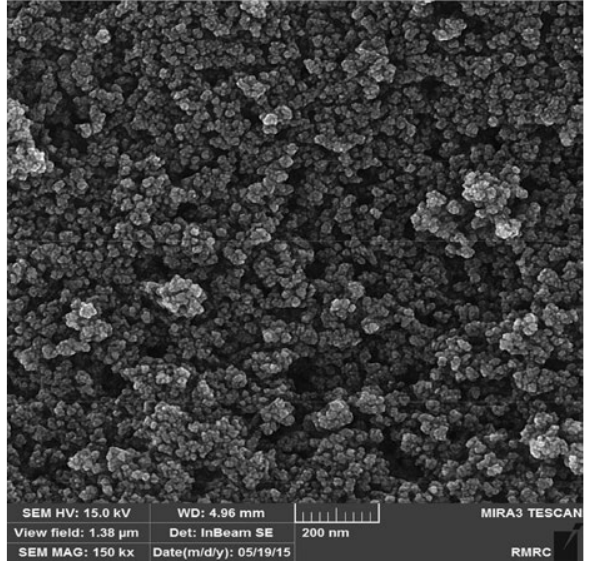
Figure 1. FE-SEM image of Fe O @SiO -OSO H nanocomposite 3 4 2 3 Further information about the chemical structure of Fe O @SiO -OSO Hnanocomposite was obtained from 3 4 2 3 FT-IR spectroscopy (Figure 2). The analysis indicated three